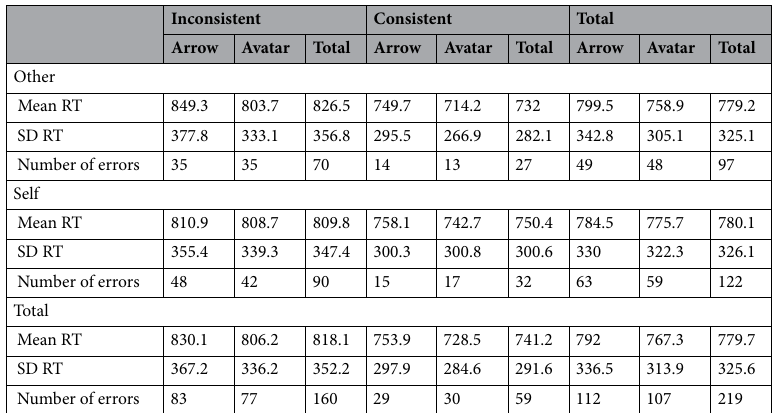
Table 1. Mean reaction times (RT) presented as mean ± standard deviation (SD) (N = 1308 observations by cell) and number of errors (N = 1304 observations by cell). N = 82 participants.